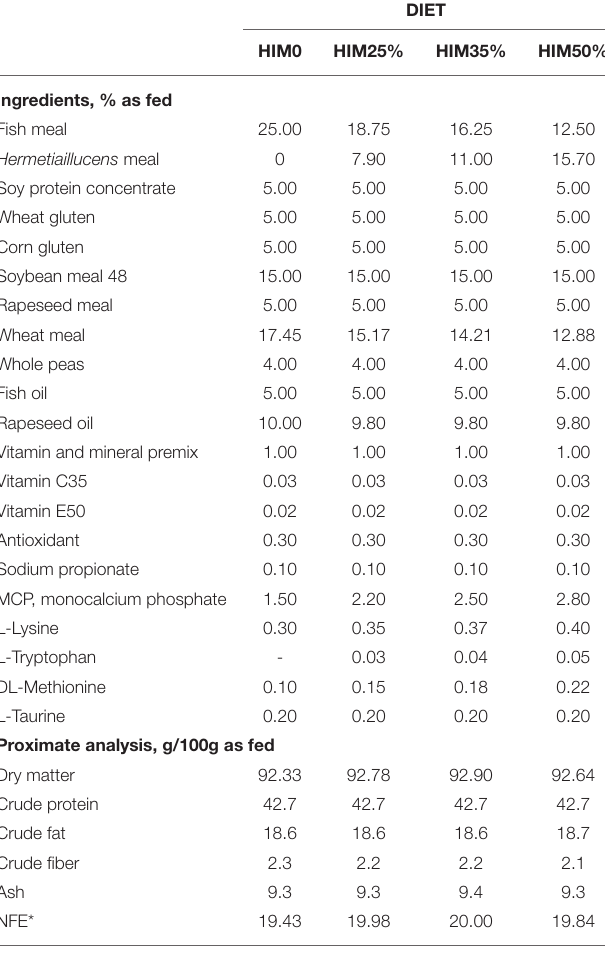
TABLE 1 | Ingredients and proximate composition of the experimental diets.